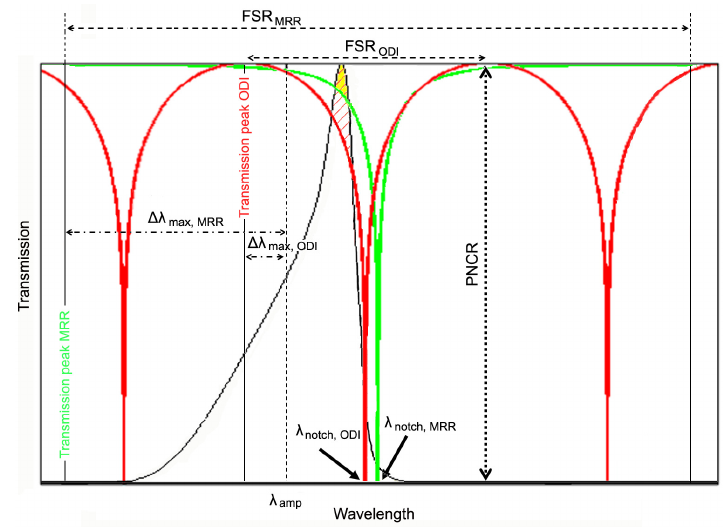
Figure 5. ODI (red color) and MRR (green color) spectral response together with spectrum at SOA output (black color). The red-colored oblique line and the yellow-colored zones show the red-shifted spectral components, which are filtered by the ODI and MRR,